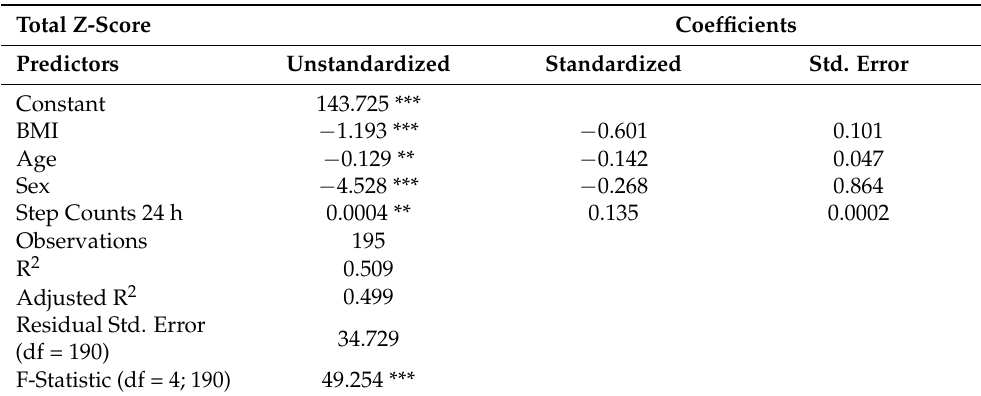
Table 2. Linear regression model with the total Z-score of DMT 6–18 as dependent variable and adjusted predictors: BMI, age, sex and step counts in 195 children.